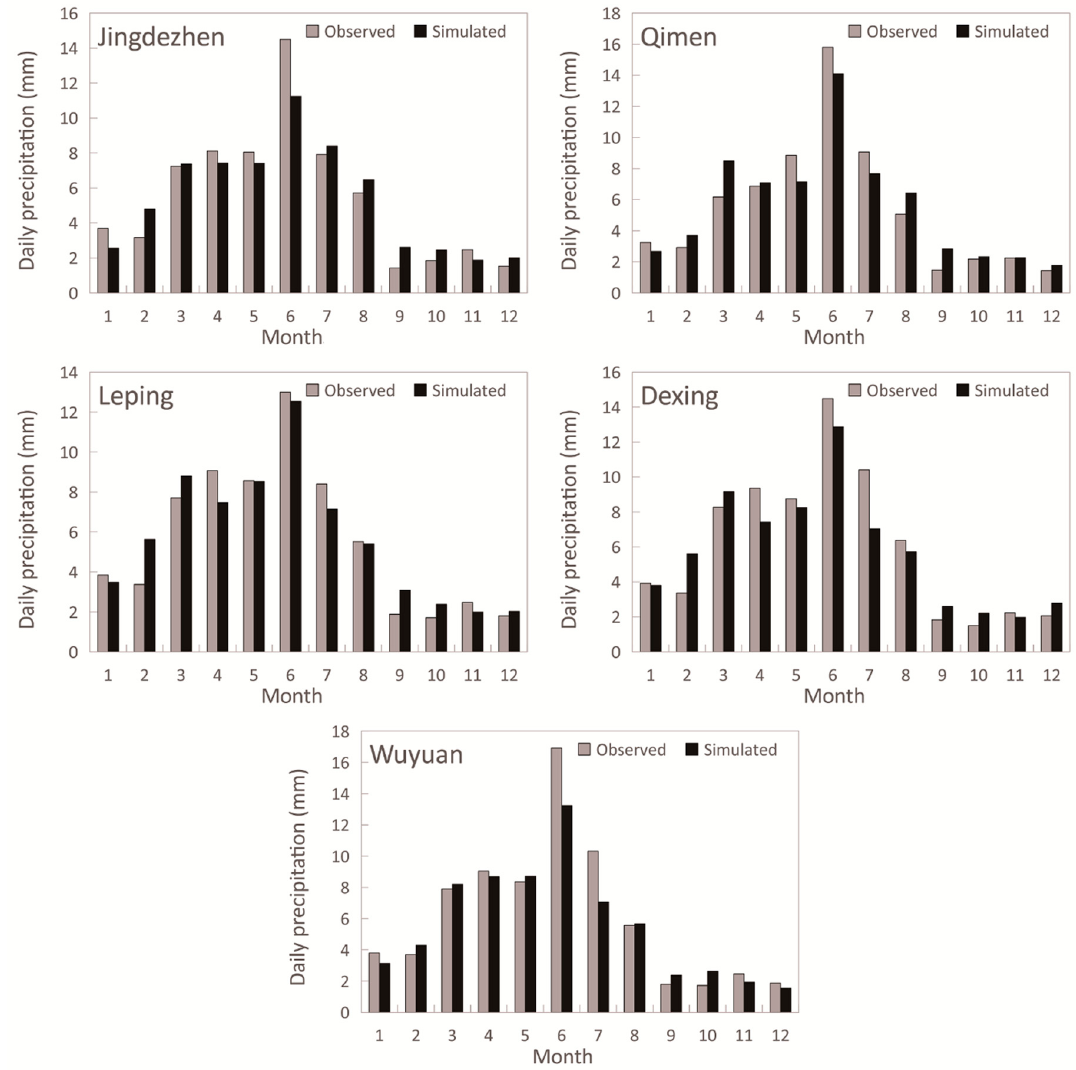
Figure 2. Observed and simulated daily precipitation for the five meteorological stations in the validation period .